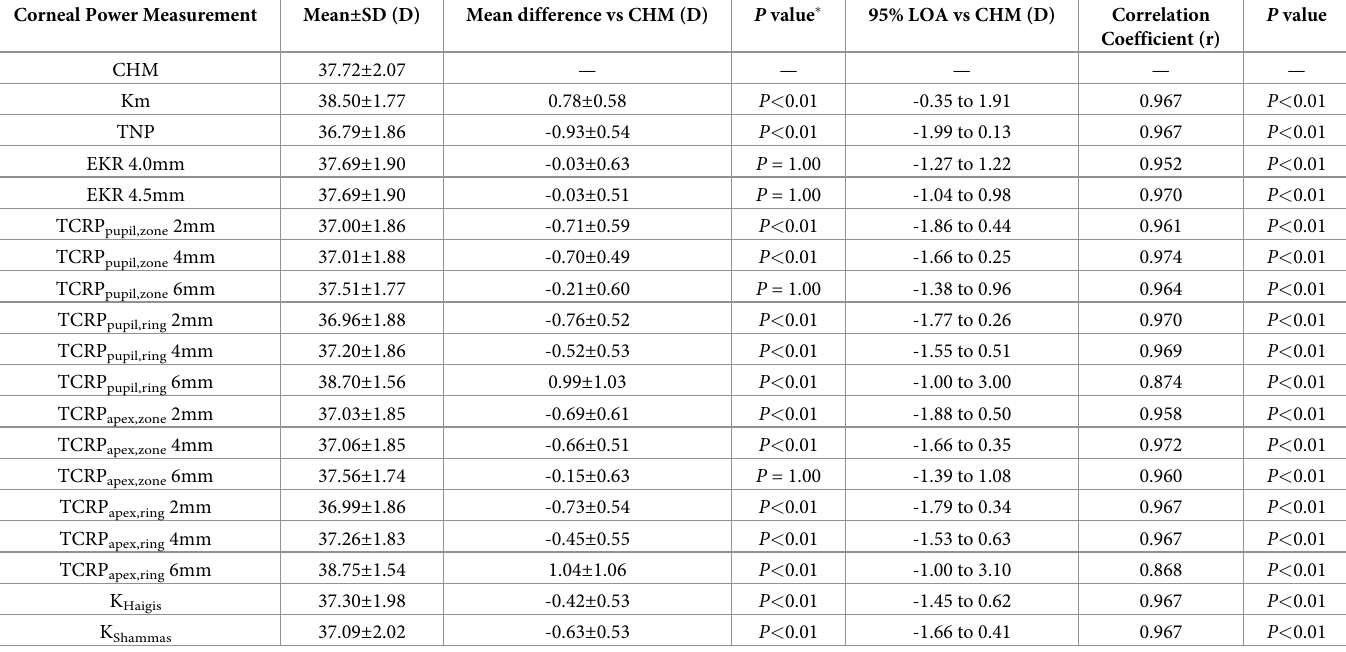
Table 2. Comparison and correlation of four modalities of TCRP and other keratometric parameters with the CHM value in eyes following SMILE surgery (n = 40). Corneal Power